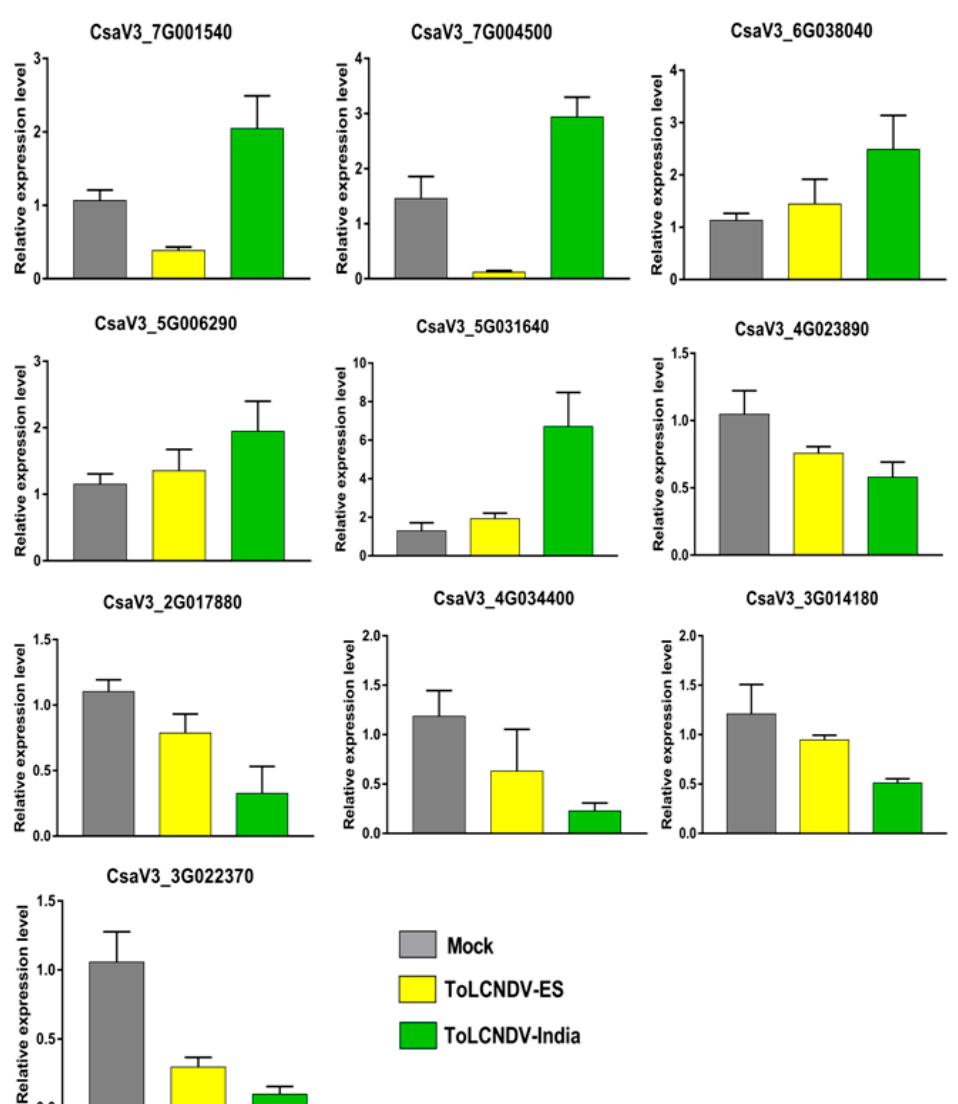
Figure 8. Quantitative RT-PCR to validate the RNA-seq data. Ten genes, including two genes that had opposite expressions, three upregulated genes, and five downregulated genes, were validated in the mock and infected plants.